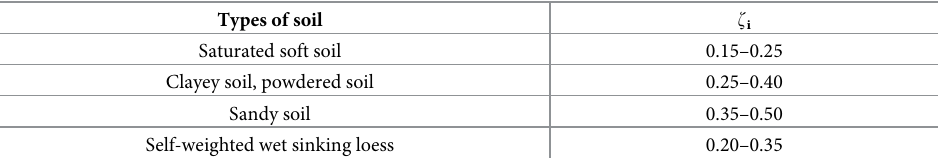
Table 2. Negative frictional resistance coefficient z i